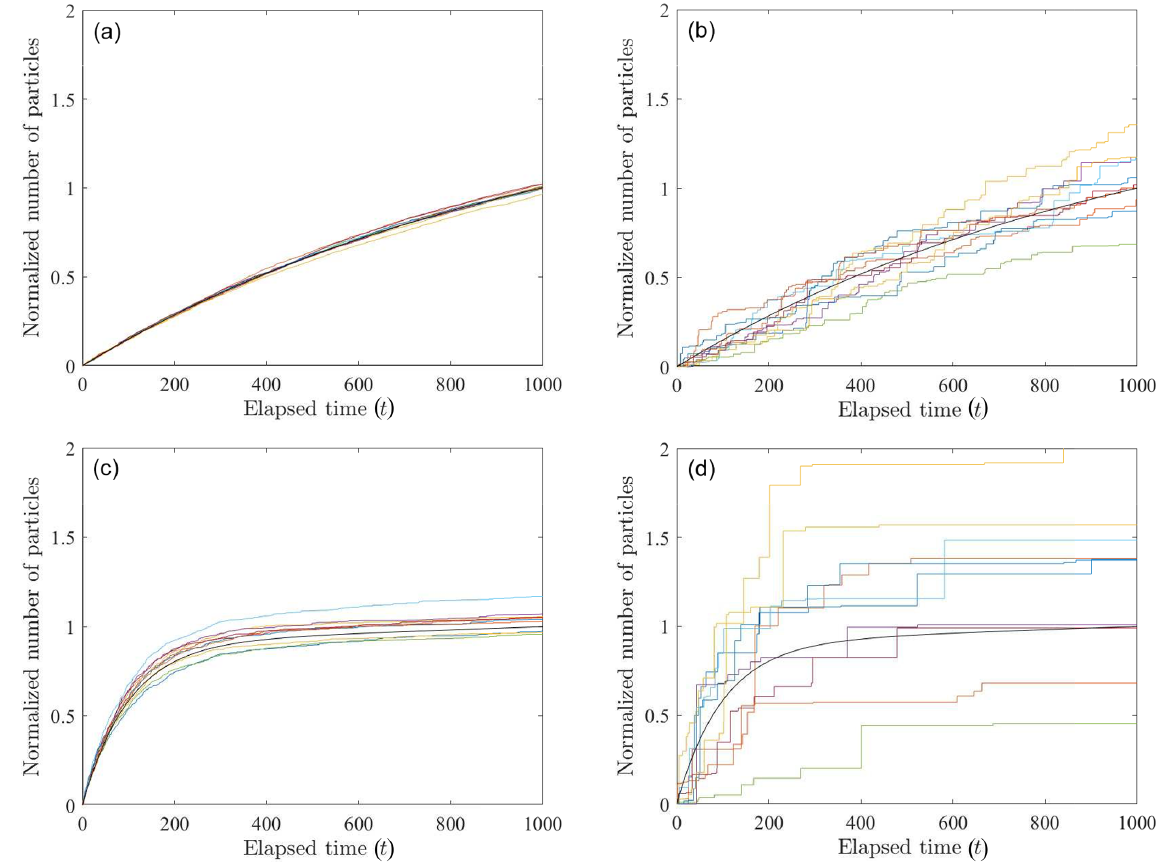
Figure 6. Plot of 10 realizations (colored lines) of normalized number ˆ n ( x,t ) versus elapsed time t showing increasing variability with t . Plots generated with η (0) = 10, η ( ∞ ) = 0 . 1, µ n = 1000 and (a) T η = 1000, R x = 1, (b) T η = 1000, R x = 0 . 01, (c) T η = 100, R x = 1 and (d) T η = 100, R x = 0 . 01. Black line represents ensemble expected values of ˆ n ( x,t